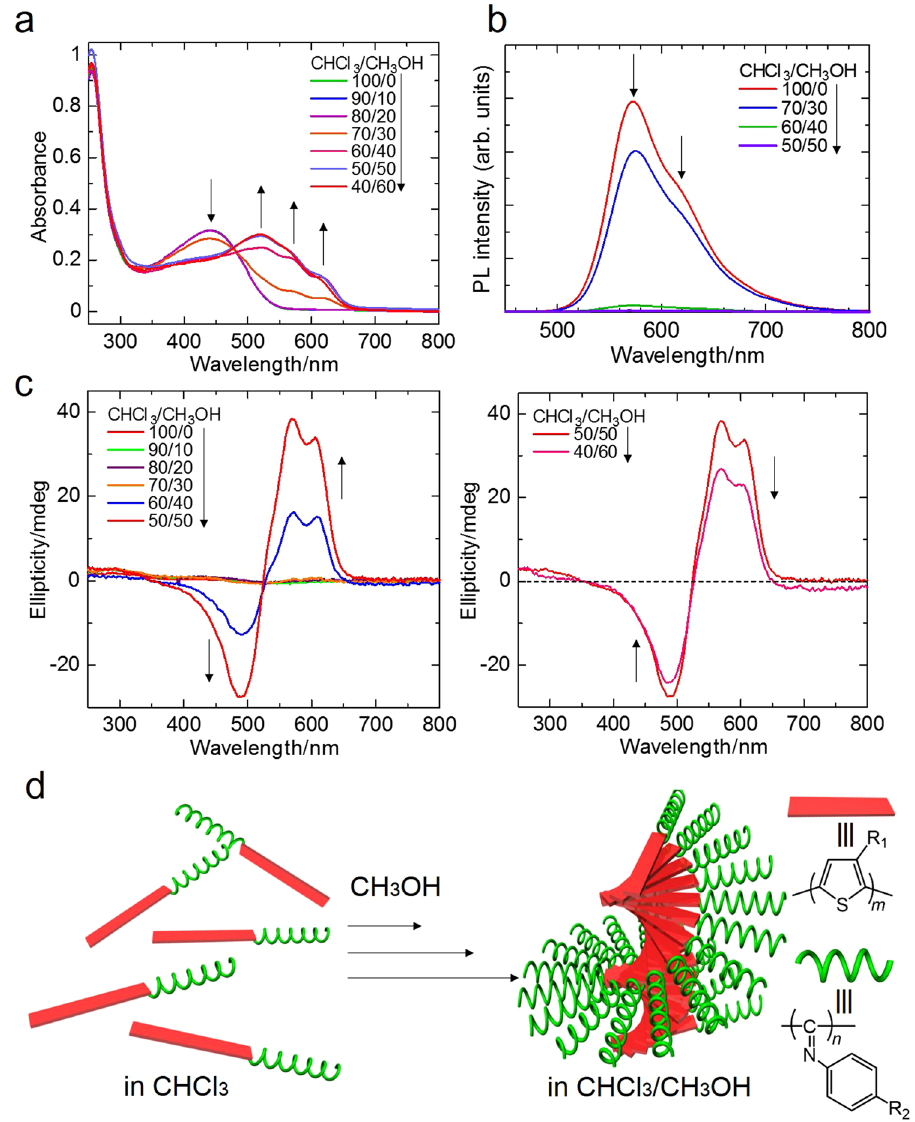
spectra of PTh- b -PPI in CHCl 3 /CH 3 OH solution (0.02 mg/ml) in various ratios. In high ratios of methanol, the spectra show film-like aggregation state. ( d ) Schematic illustration of PTh- b -PPI chiral aggregation in good/ poor solvent